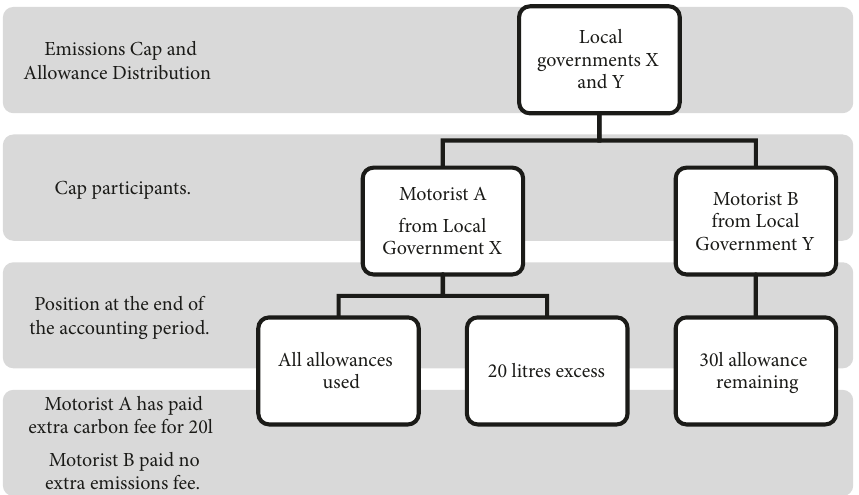
Figure 4: Motorists A and B’s fuel consumption at the end of the period.